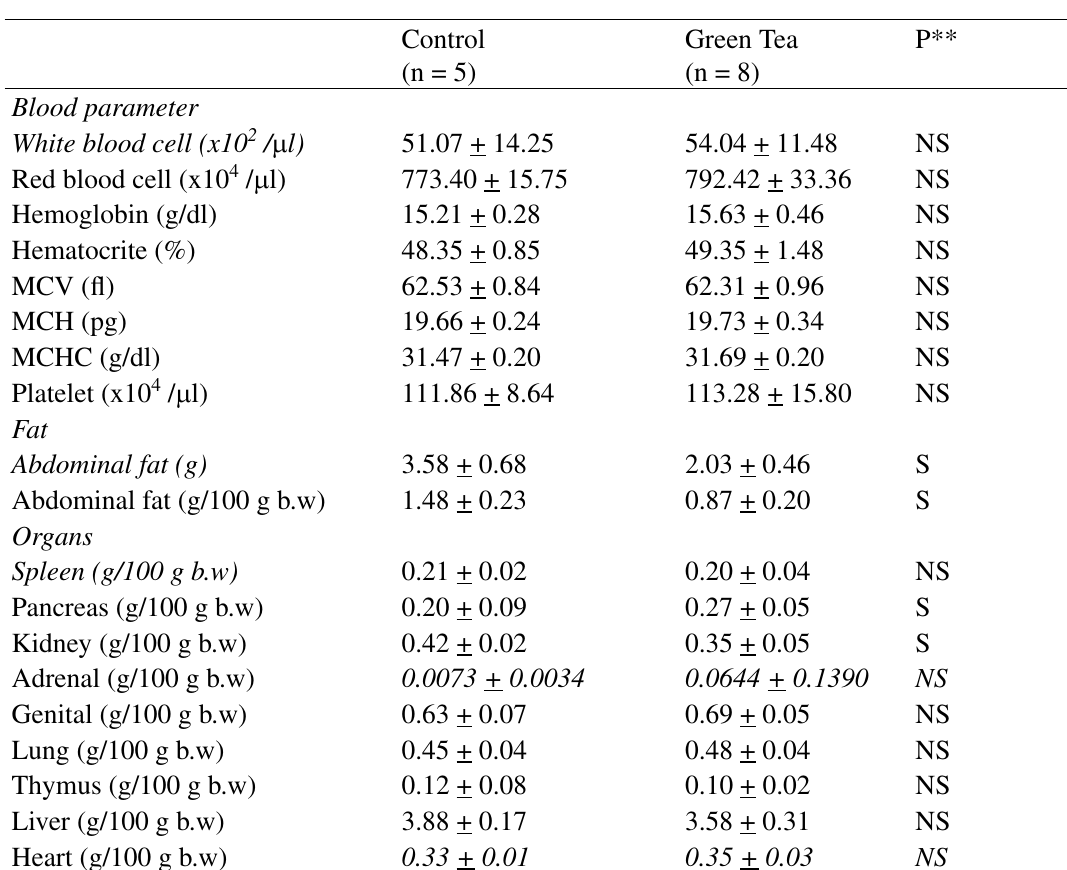
Figure 1. Structure of (-)-epigallocatechin gallate (EGCG) from green tea. Tabel 1. Effect of green tea extract on blood parameters, fats and organs weight of Fructose-Fed Rat